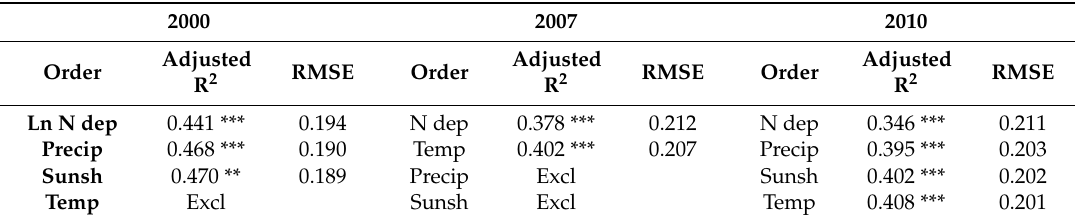
Table 5. Order of variables entered into the model and adjusted R 2 for croplands, according to the addition of a new variable to the model: N dep: N deposition, Ln N dep: Natural logarithm of N deposition, Temp: Temperature, Precip: Precipitation, and Sunsh: Sunshine. Excl: Variable excluded from the model. ** Statistically significant p < 0.01. *** Statistically significant p < 0.001.